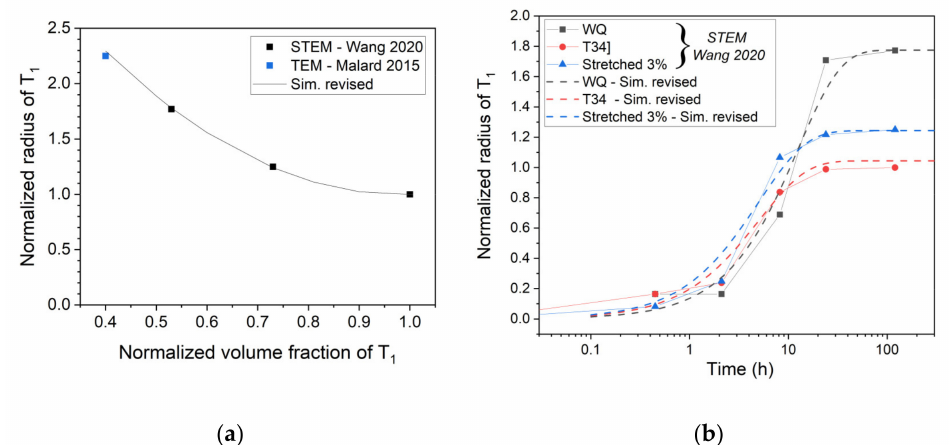
Figure 10. ( a ) The evolution of the simulated and experimental (Malard et al. [6] and Wang et al. [11]) normalized radius vs. volume fraction of the T 1 precipitates after 30 h of heat treatment at 155 ◦ C; ( b ) the evolution of the simulated and experimental [11] normalized radius of the T 1 precipitates during artificial aging at 155 ◦ C with different pre-treatments. The revised model is used for the simulations.